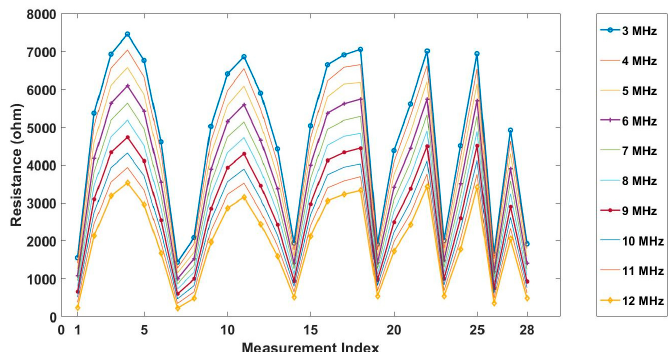
Figure 7. The resistance measurements of background conductive medium at freqeuncies from 3 to 12 MHz.